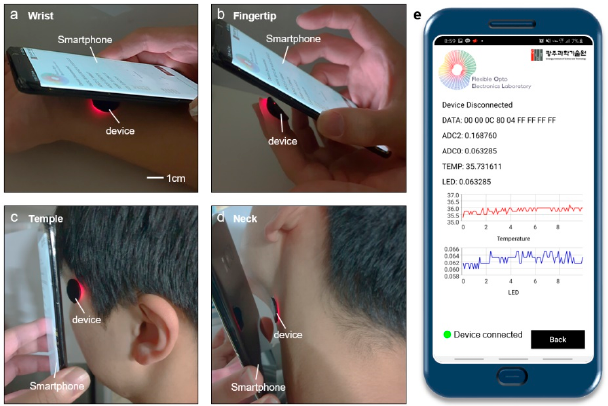
Figure 6. Measurement at various sites such as ( a ) fingertip, ( b ) wrist, ( c ) temple, ( d ) neck. ( e ) Cap- tured image of the smartphone application of smartphone displaying data measured at